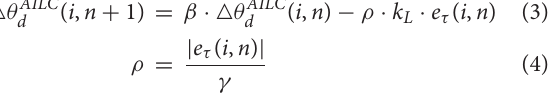
and timing values could derive nine different assistance patterns ( Figure 2 ). Compared to peak torque timing and magnitude,